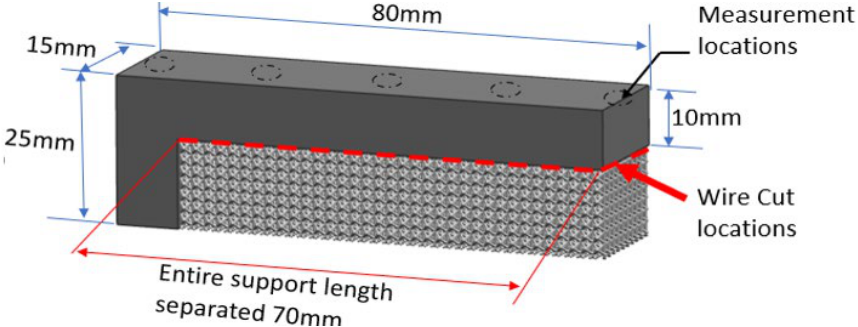
Figure 4. Cantilever test sample with perforated block support for benchmark study.